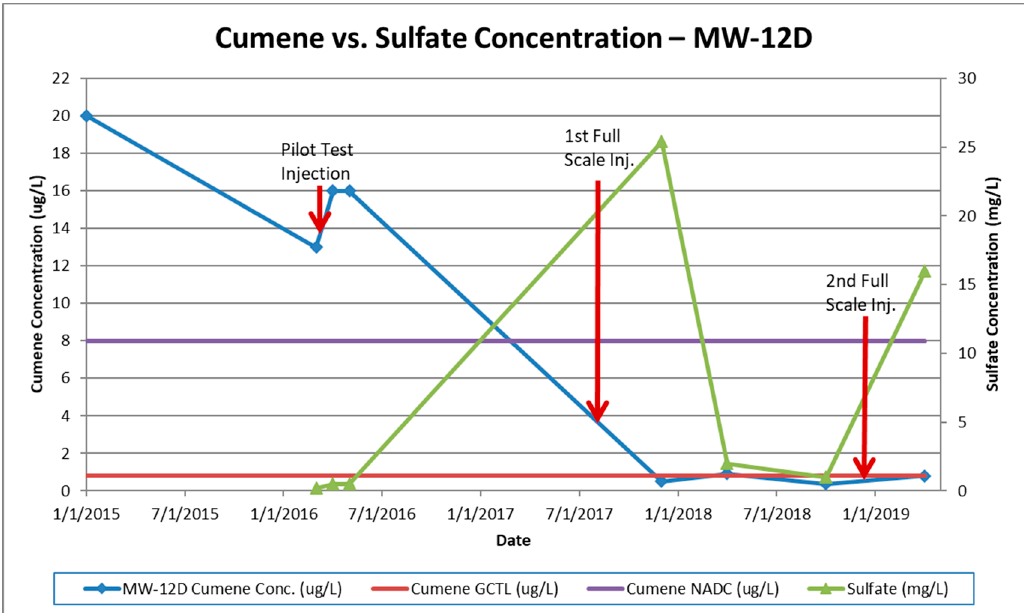
Figure 4. Cumene vs. sulfate concentrations in MW-12D.